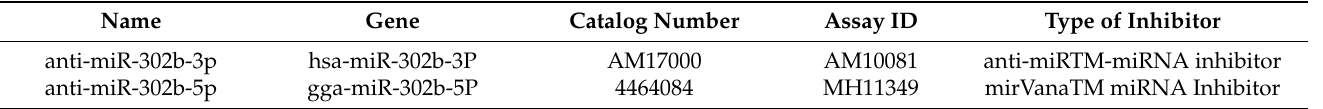
Table 3. Inhibitors used at the miRNA inhibition